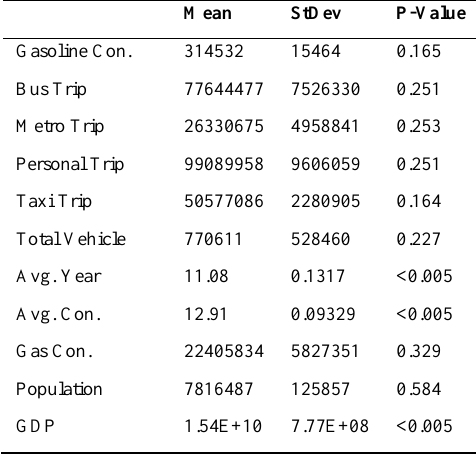
Table 9. Normality test for data before rationing.